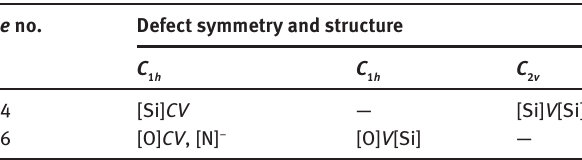
The labeling convention follows the one defined in Figure 8.